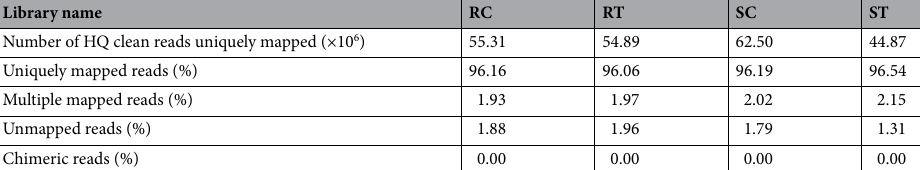
Table 2. Sequence alignment statistics of the four transcriptome libraries in inoculated Ae. tauschii accessions with P. triticina pathotype CDHLQ and mock-inoculated ones at the seedling stage with the reference